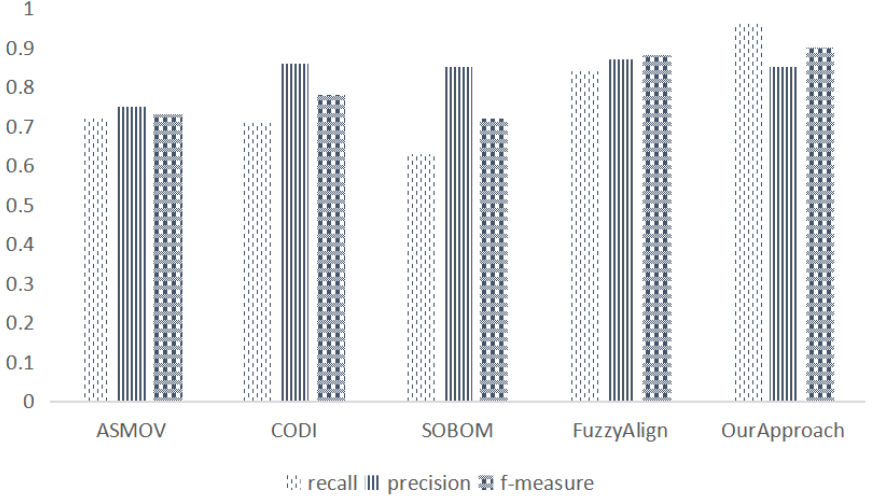
Figure 11. Comparison of Our Approach and the Advanced Sensor Ontology Matching Systems on CSIRO-MMI matching